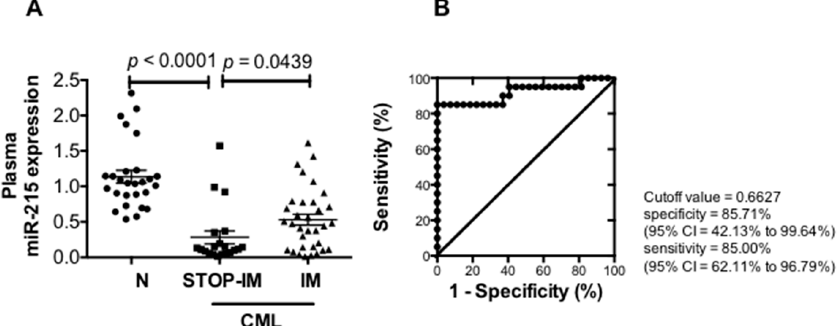
Figure 2. Expression of miR-215 ( A ). The cutoff level for miR-215 expression between the STOP-IM and control groups ( B ). The area under the curve level was 0.9204. The cutoff value was thus determined to be 0.6627, which was used in the following analyses of plasma miR-215 expression.